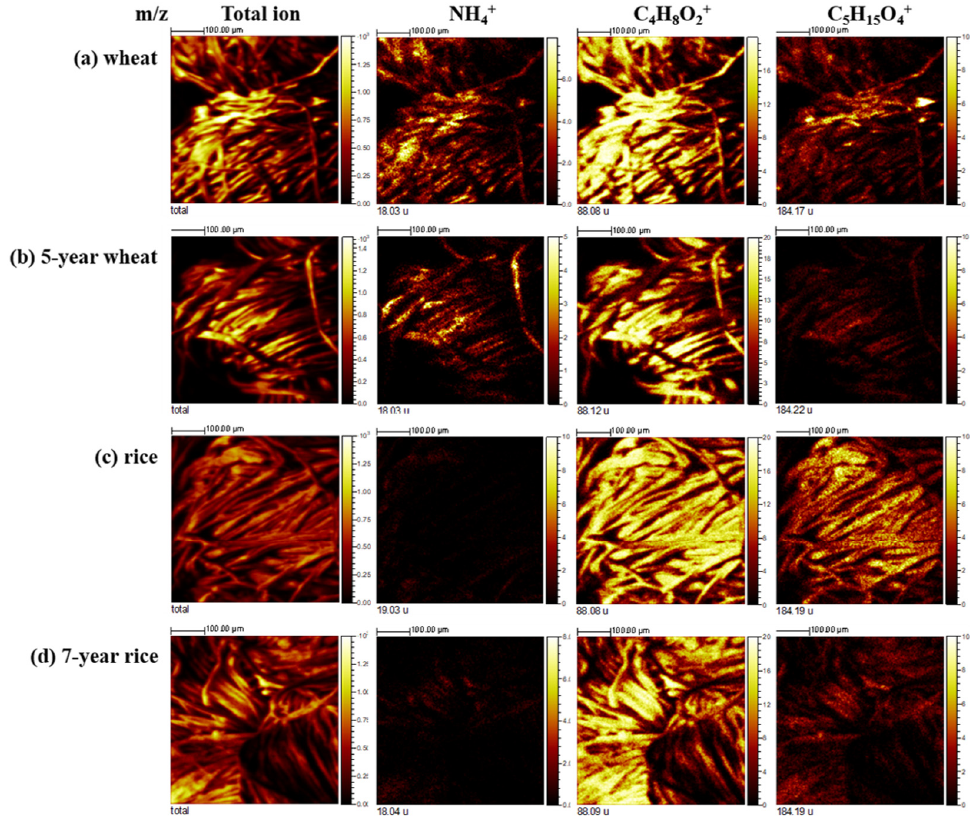
Figure 7. The positive ion ToF-SIMS images of total ion, m / z 18, 88 and 184 for cotton textiles coated with: ( a ) fresh wheat starch, ( b ) 5-year fermented wheat starch; ( c ) fresh rice starch, and ( d ) 7-year fermented rice starch.